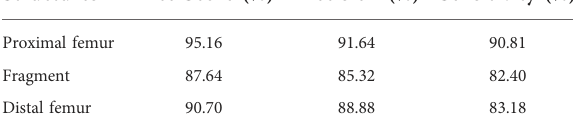
TABLE 4 Segmentation accuracy of human experts in the Human- computer competition.